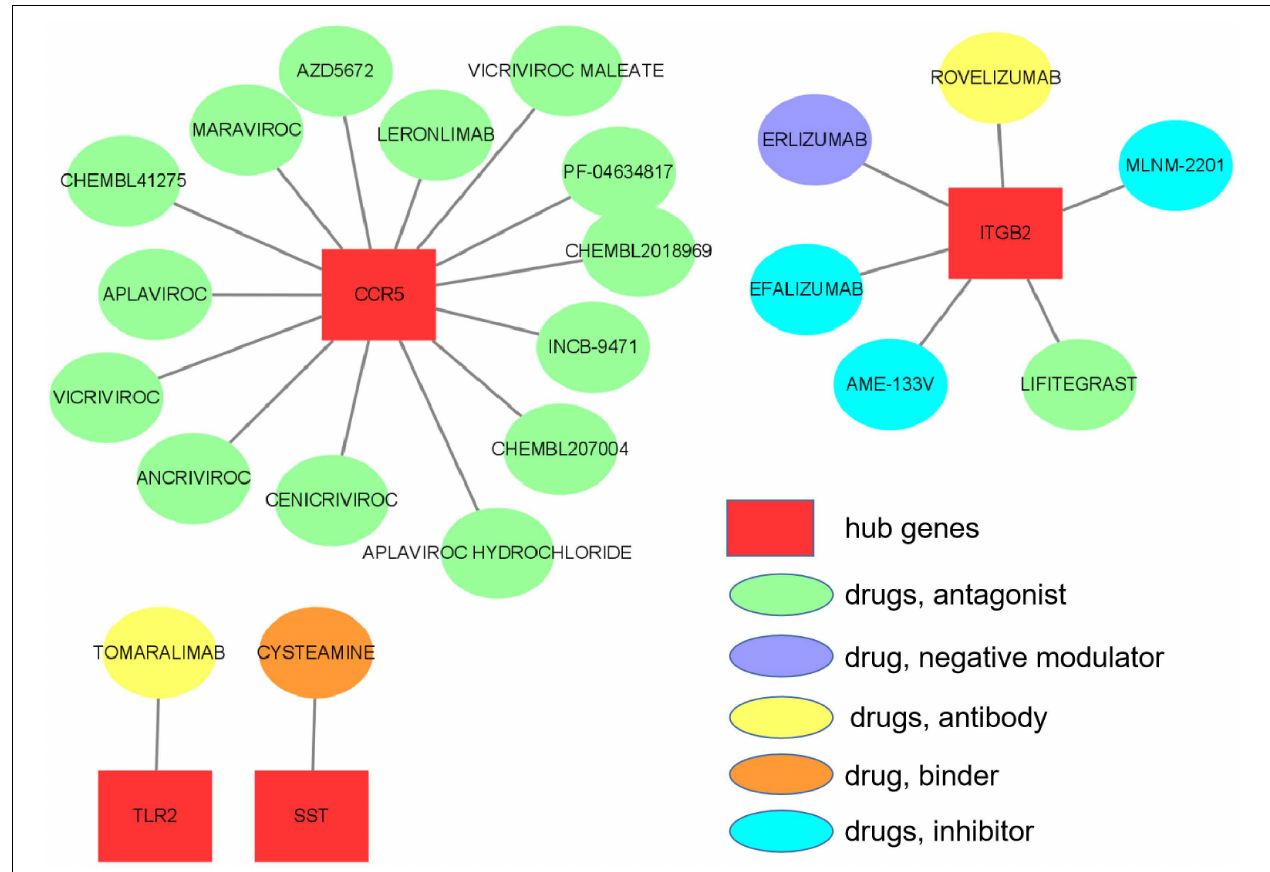
FIGURE 9 | Hub gene–drug interactions that were found in the Drug–Gene Interaction Database (DGIdb) for four hub genes, TLR2 , SST , ITGB2 , and CCR5 , are visualized using Cytoscape